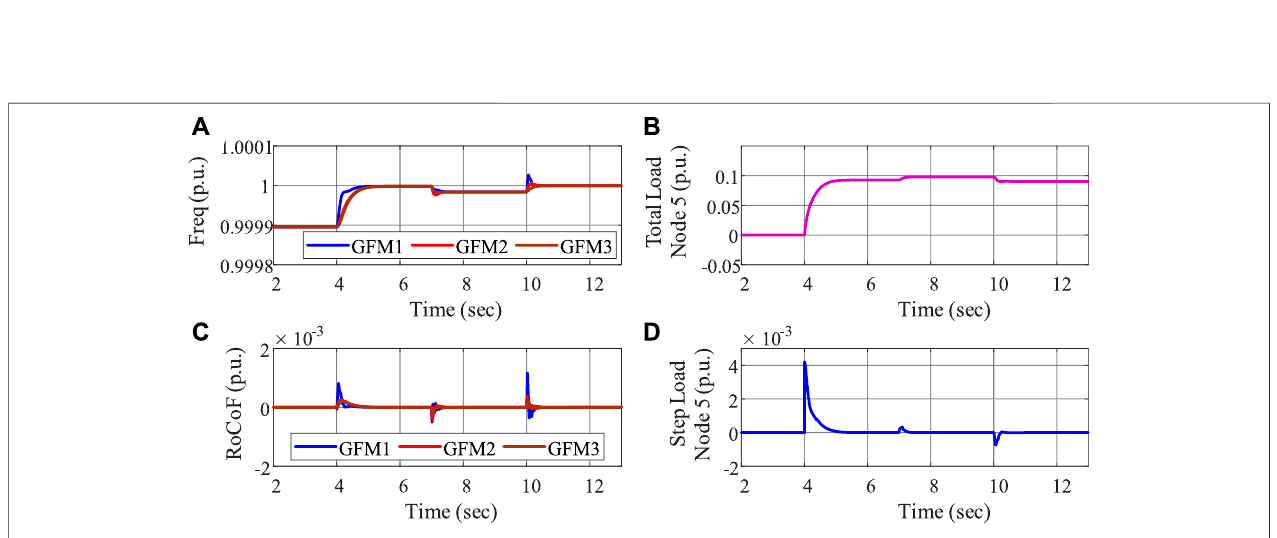
FIGURE 4 | Dispatchable load capacity constraint evaluation: (A) frequency, (B) total load decrease, (C) RoCoF, and (D) load ramping.